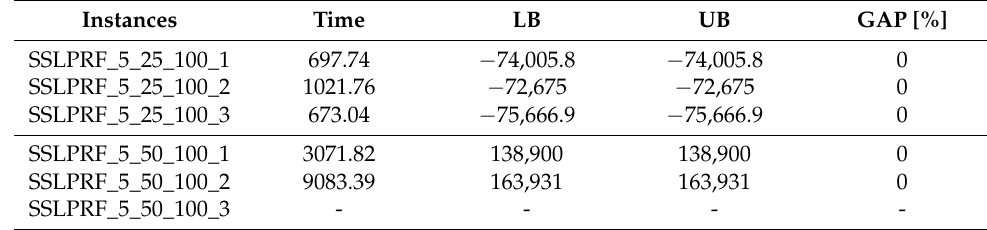
Table 4. Results of DSP with DW Branch-and- Bound on SSLPRF instances.